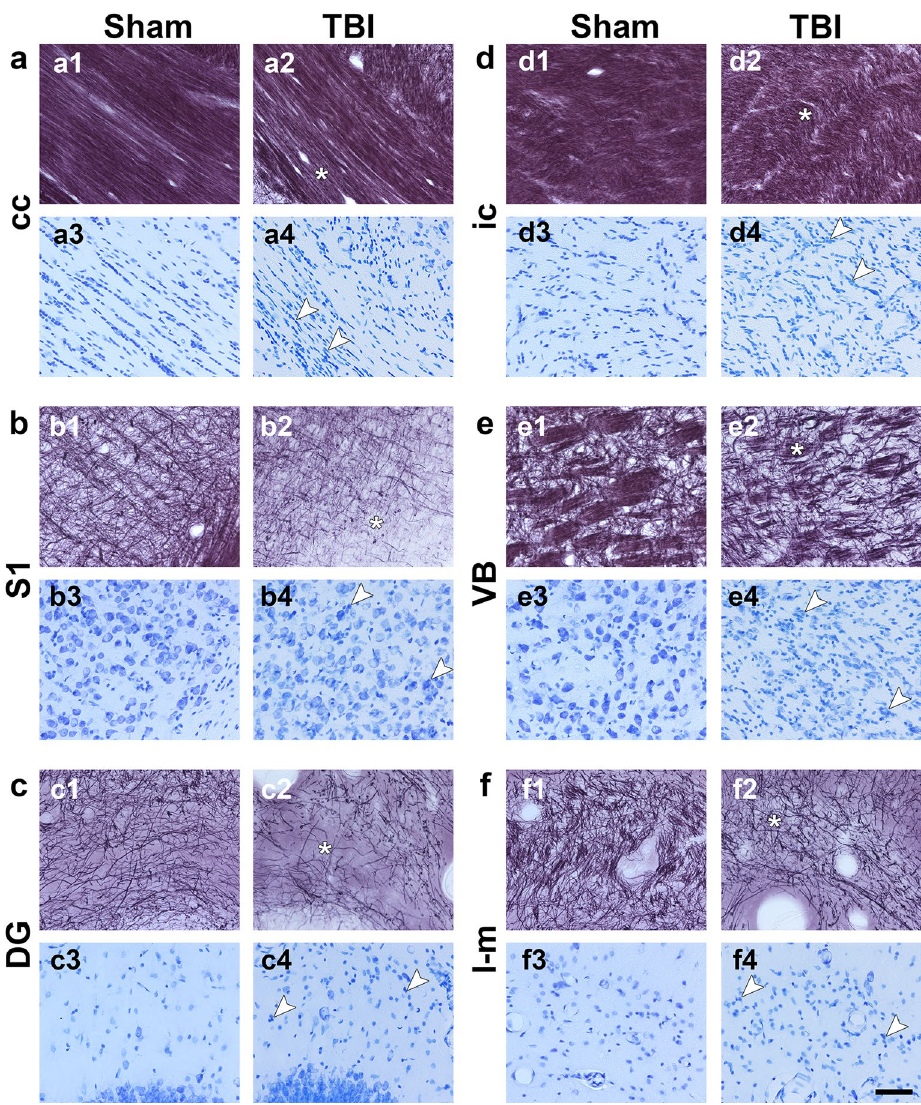
Figure 8. Representative photomicrographs of Nissl and myelin stainings from a sham-operated and a TBI rat. Asterisks indicate a decrease in myelin density and arrowheads increased cell density (small and intense blue cells) associated to gliosis. Abbreviations: cc, corpus callosum; DG, dentate gyrus; ic, internal capsule; l-m, stratum lacunosum-moleculare; S1, primary somatosensory cortex; VB, ventrobasal complex. Scale bar: 50